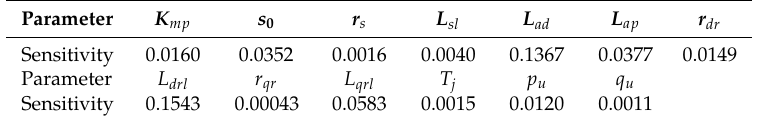
Table 2. Parameter sensitivity absolute